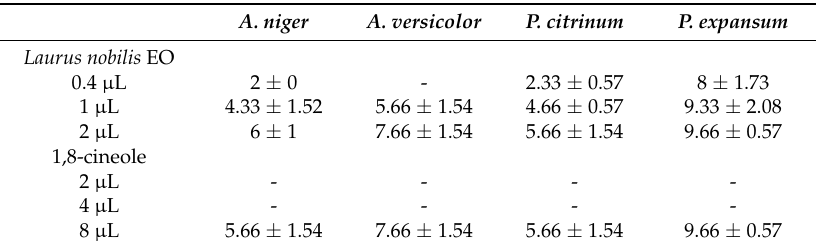
Table 4. Antifungal activity of L. nobilis essential oil and of 1,8-cineole.